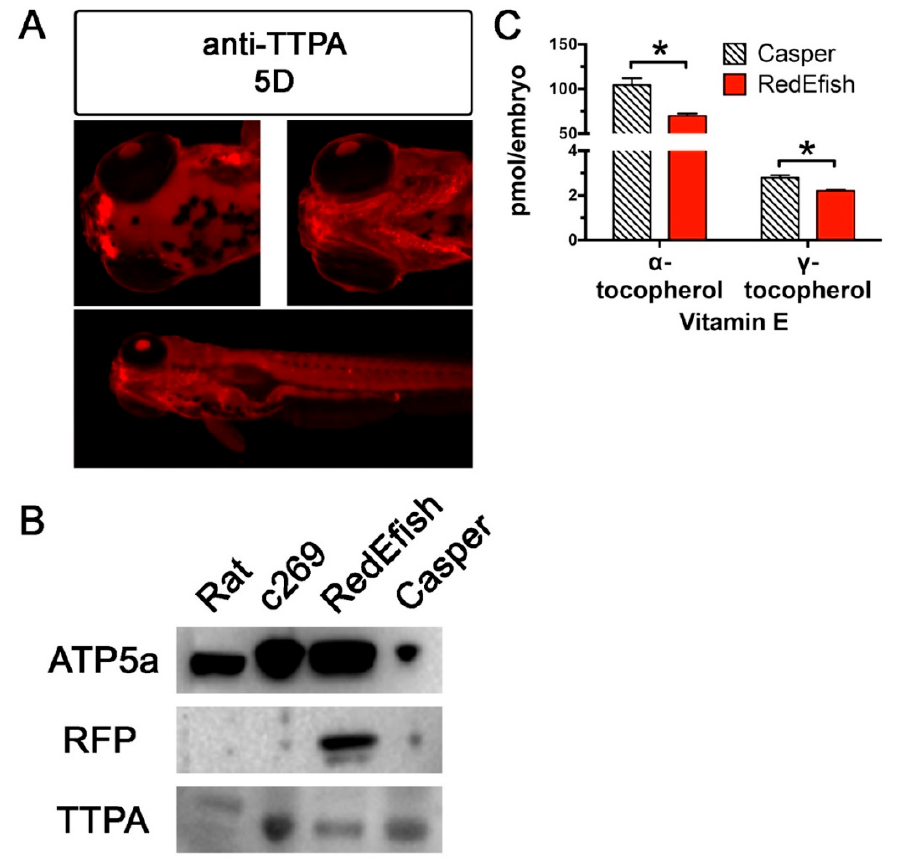
Figure 3. Immunolocalization and Western blot of Ttpa protein in rat liver and zebrafish embryos (c269, RedEfsh and Casper). ( A ) The 5D strain fish expressed Ttpa in olfactory pits, gill arches and gut lining at 5 dpf. Anti-Ttpa was used to detect and validate Ttpa protein expression in 5D embryos initially to determine regionalization followed by in vivo observation. Figure A panels were gener- ated with the BZ-x700 microscope, processed with BZ-X Analyzer Software with image adjustments equally applied across all images in Adobe Photoshop. All images are taken at 2× magnification at the same exposure protocol. This figure was created with Adobe Photoshop, v21.2.1. ( B ) The same anti-Ttp antibody, used in a Western blot, confirmed that Ttpa expression is not affected by the insertion of the mScarlet coding sequence in RedEfish relative to Casper or the c269 transgenic lines. This antibody reacts poorly with rat liver protein. RFP was also detected in the RedEfish embryos, although not detected by blot in the rat liver, c269 or Casper zebrafish embryos. ( C ) Shown are α - and γ -tocopherol concentrations (mean ± standard deviation, pmol/embryo, * = Student’s t -test, p = 0.002 and p = 0.001, respectively) in 5 day old Casper (hatched bars) and RedEfish (red solid bars) embryos ( n = 5 homogenate pools per group, n = 15 embryos per pool). Both RedEfish and Casper embryos contained lower mean γ - as compared with α -tocopherol concentrations; the com- parison of logarithmically transformed data for each fish line was significantly different ( p < 0.0001, Holm-Sidak’s multiple comparisons